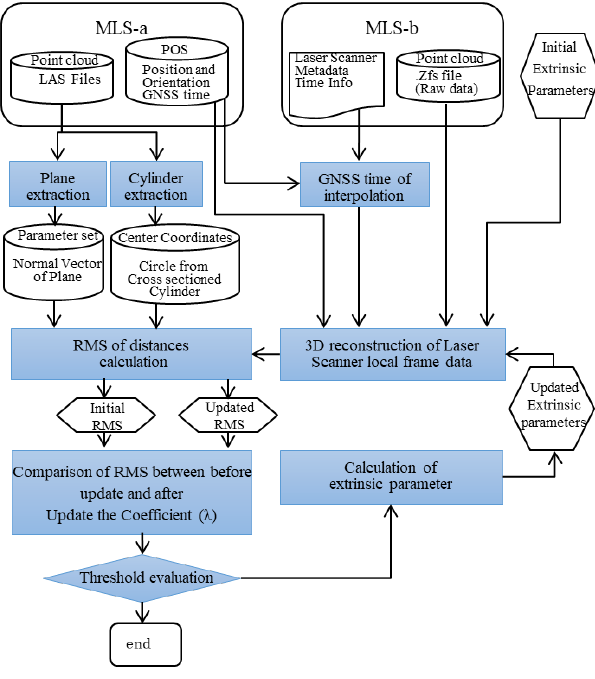
Figure 1. Work flow of the Calibration of Two MLSs